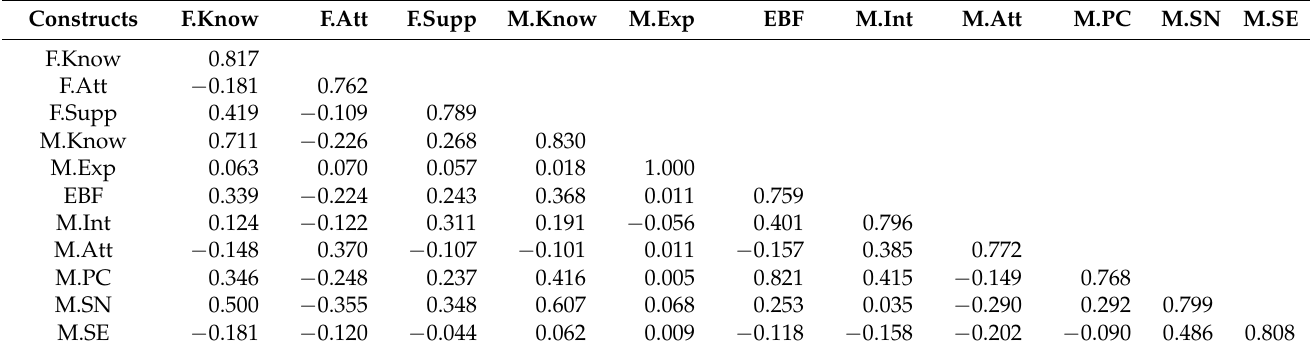
Table 3. Correlation coefficient of variables in accordance with Fornell–Larcker